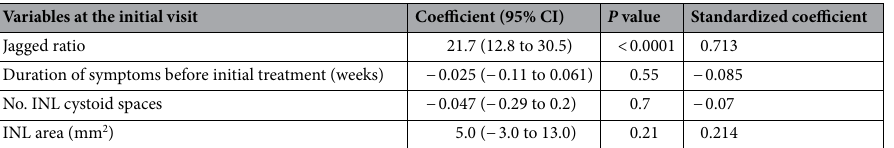
Table 2. Factors affecting the total number of anti-vascular endothelial growth factor injections over 1-year follow-up period in multivariate linear regression analysis. INL inner nuclear layer, CI confidence interval, No.